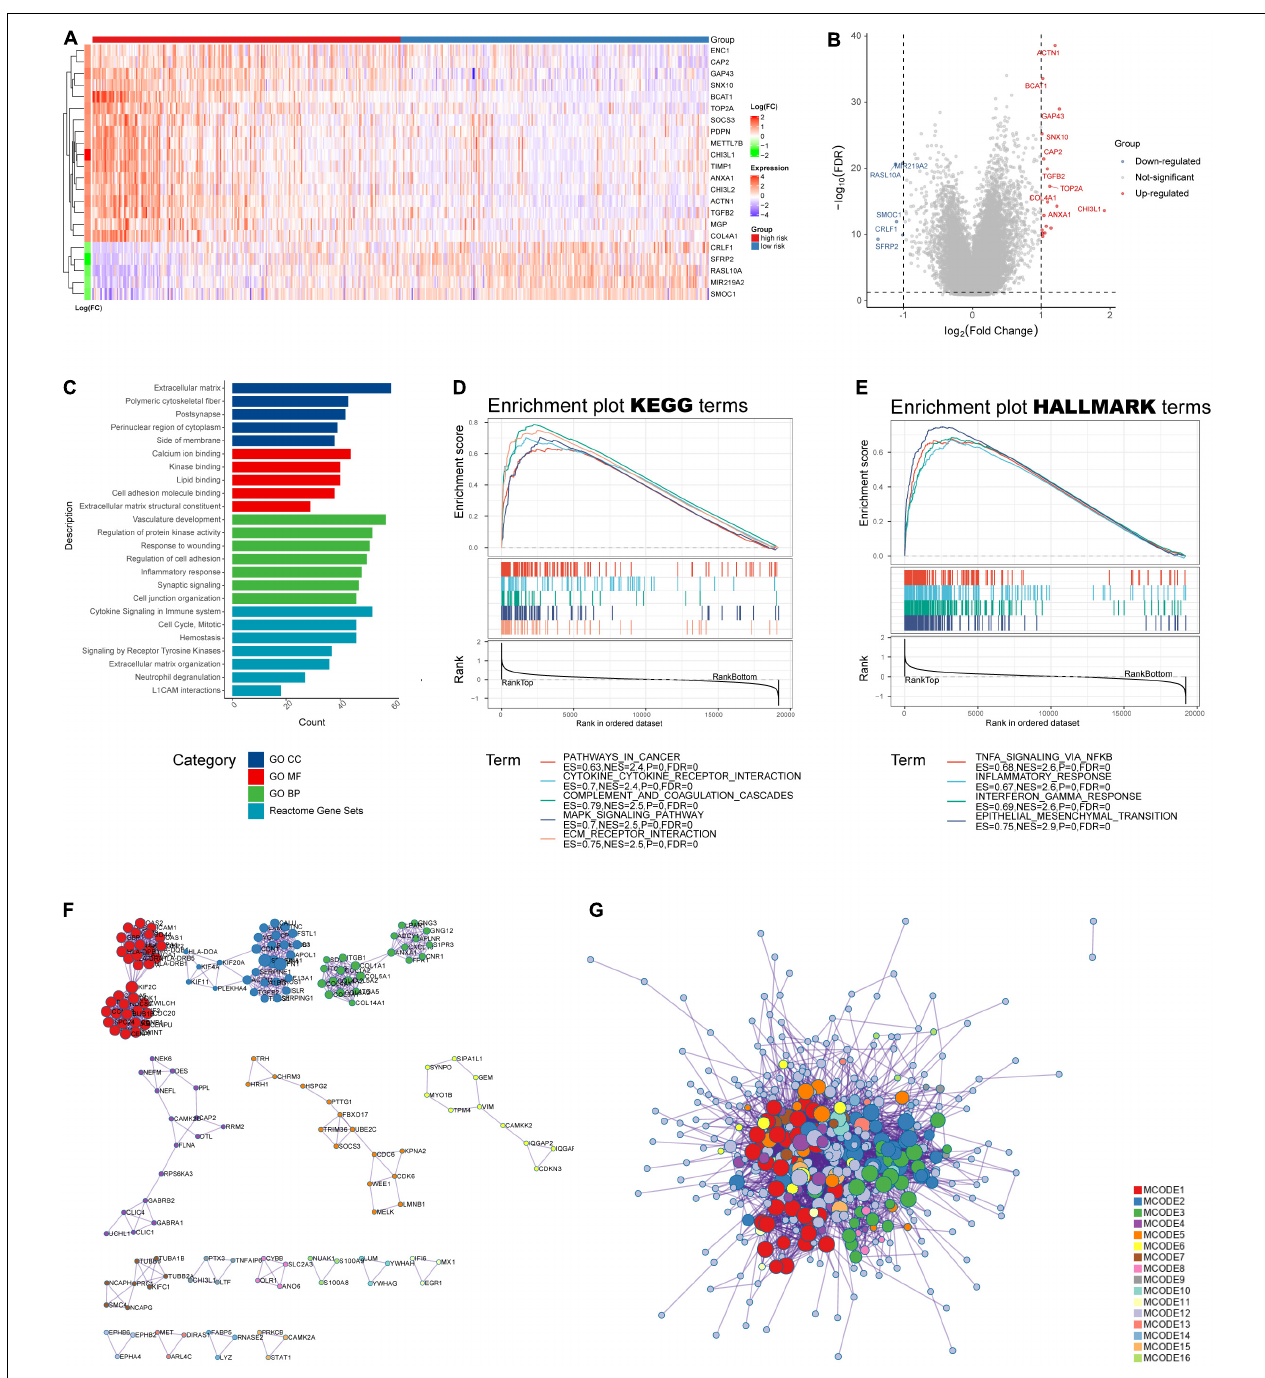
FIGURE 7 | Functional analysis of the IRRS. (A) Heatmap of differential expressed genes between high- and low-risk groups. (B) Volcano plot of differential expressed genes (log 10 FDR < 0.05, | log 2 (fold change)| > 1). (C) GO and Reactome enrichment analysis. (D,E) GSEA analysis for KEGG and HALLMARK terms. (F,G) Protein–protein interaction displayed by enriched MCODE